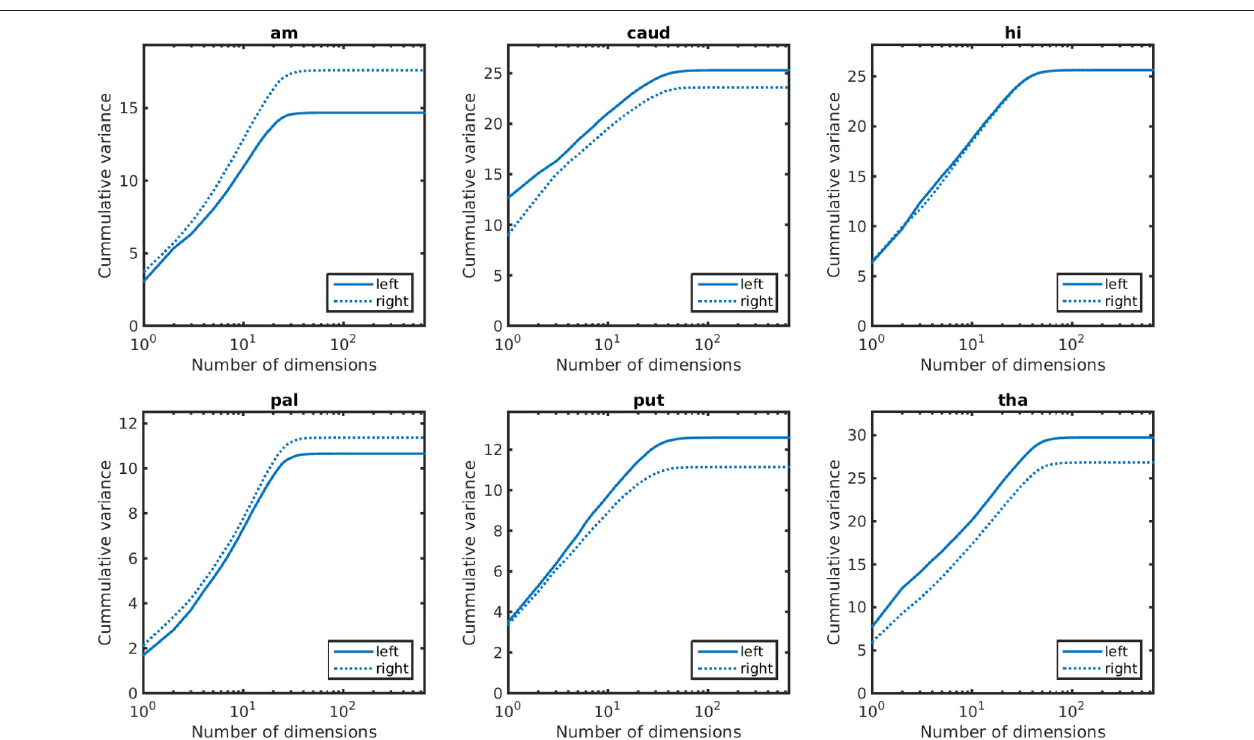
FIGURE 3 | Cummulative variance as a function of dimensions for anatomical priors. In lexicographic order: amygdala, caudate, hippocampus, globus pallidus, putamen, thalamus.